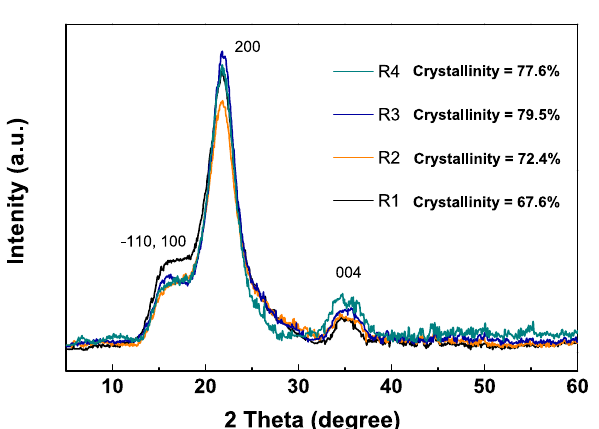
Figure 4. XRD patterns of the basal rice culms, which have been reduced into a fine powder before